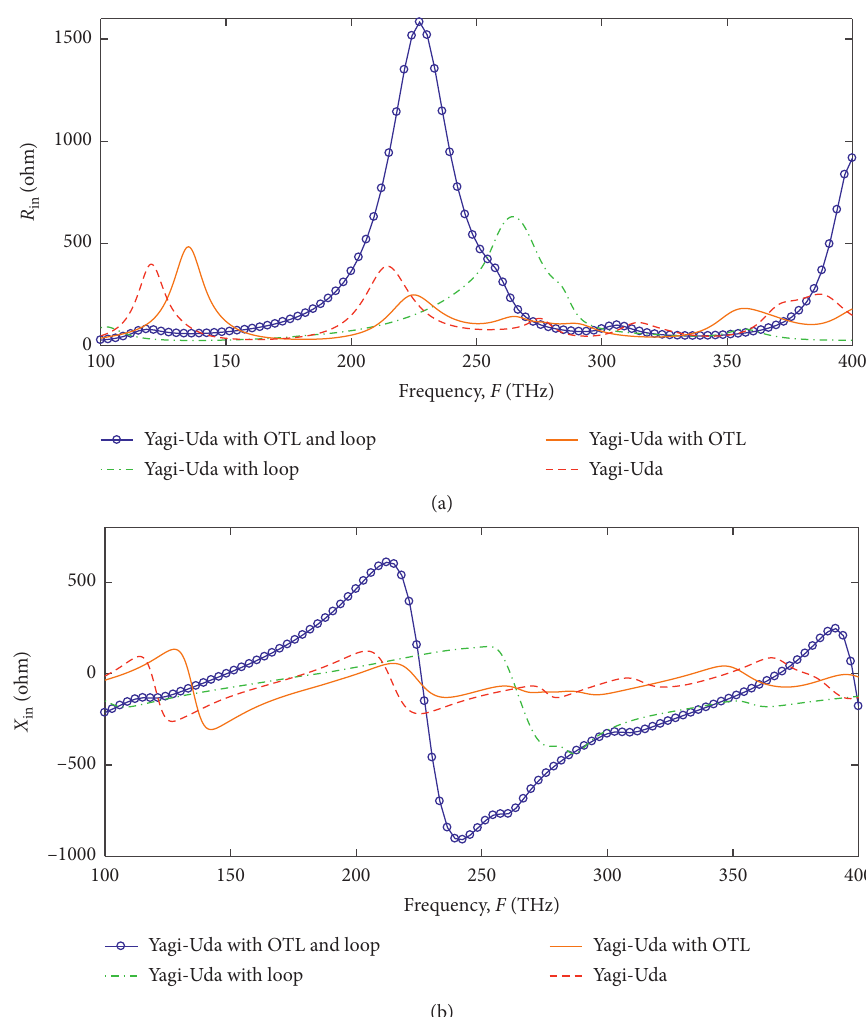
Figure 4: Variation of input impedance in frequency of the four YU nanoantennas: (a) R